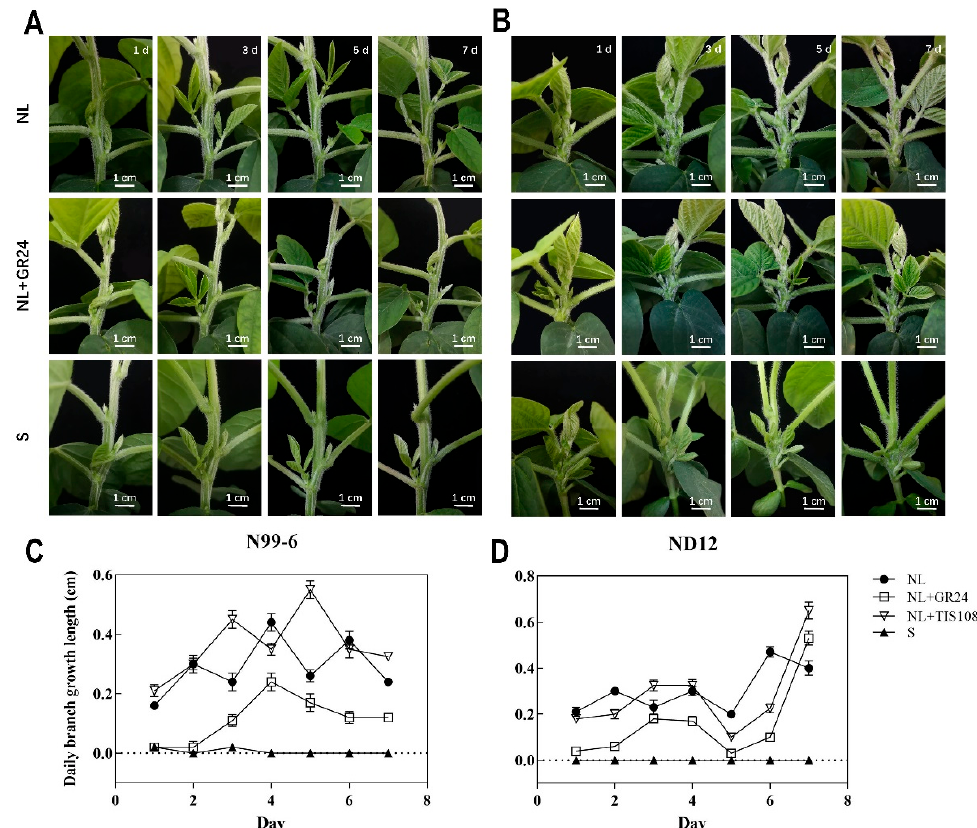
Figure 9. Changes of branching length of ND12 and N99-6 under normal light (NL), normal light spraying GR24 (NL+GR24) and shading conditions (S) for one week. ( A , B ) Changes in the length of axillary buds of N99-6 and ND12 under normal light, GR24 and shade treatment on 1/3/5/7 day. The size of the soybean branches can be estimated by using the 1 cm scale at the right bottom. ( C , D ) The average daily branch growth length of N99-6 and ND12 in 7 days after normal light, GR24 and shade treatment. Error bars represent standard errors.